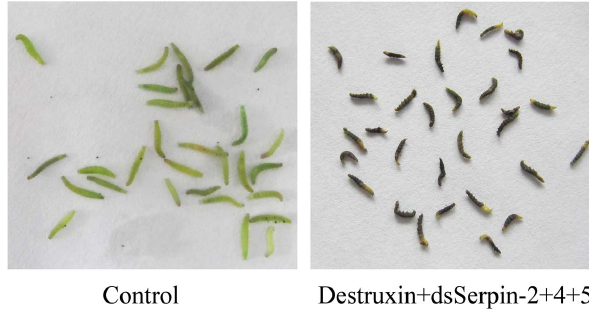
Figure 12. Melanization of Plutella xylostella treated with destruxin and dsSerpins. The treatment group was injected with 2 m l of a solution containing 200 m g/ml destruxin A and a total of 5 m g dsRNA. The control treatment was injected with 2 m l of PBS